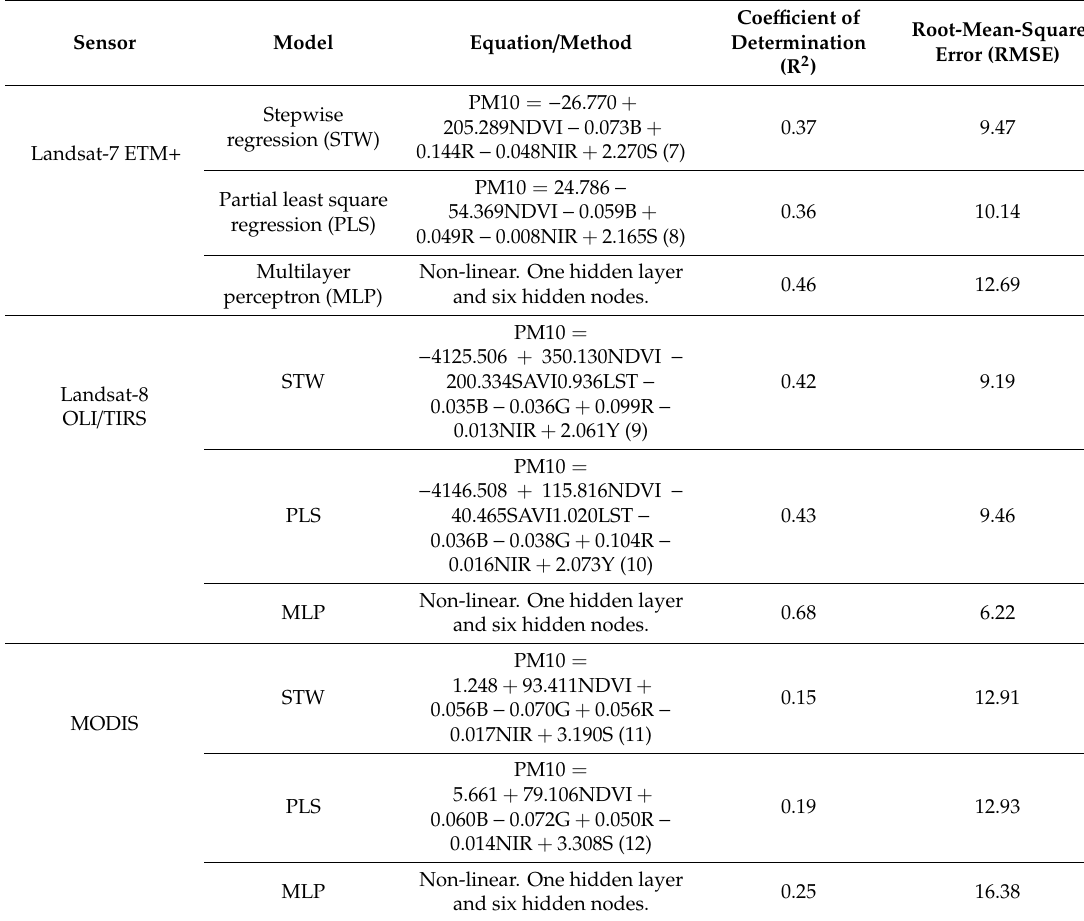
Table 4. LUR models for each sensor with di ff erent regression techniques. In the case of multilayer perceptron (MLP), the model is not